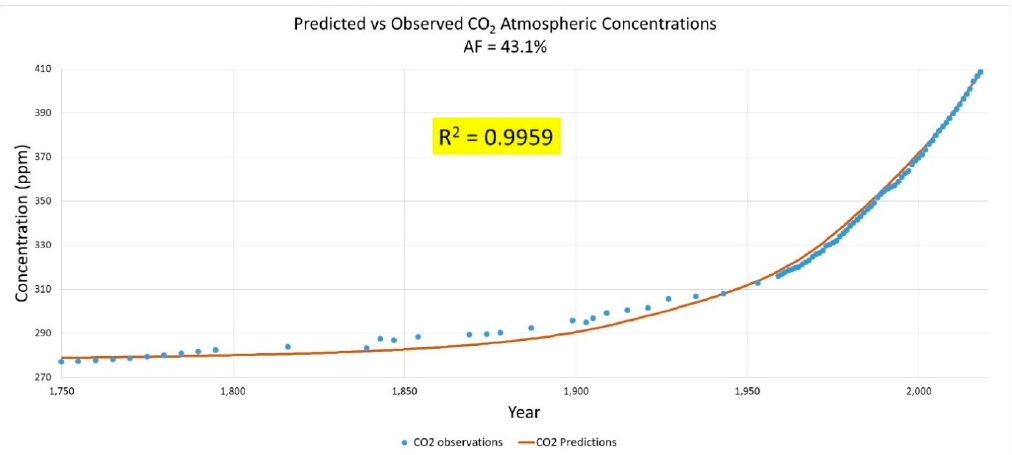
Figure 4. Comparison of predicted CO 2 concentrations with observations. Curve is best fit to data using Equation (1) with α 1 = AF = 43.1%.